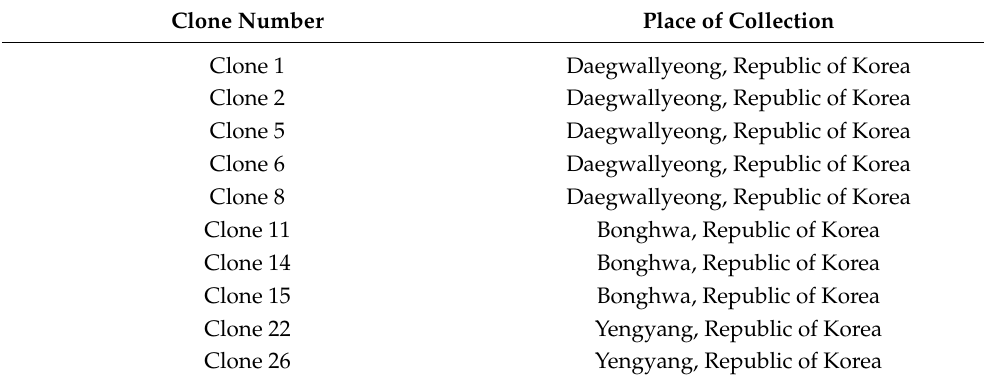
Table 1. Cnidium officinale germplasm collected from different regions of